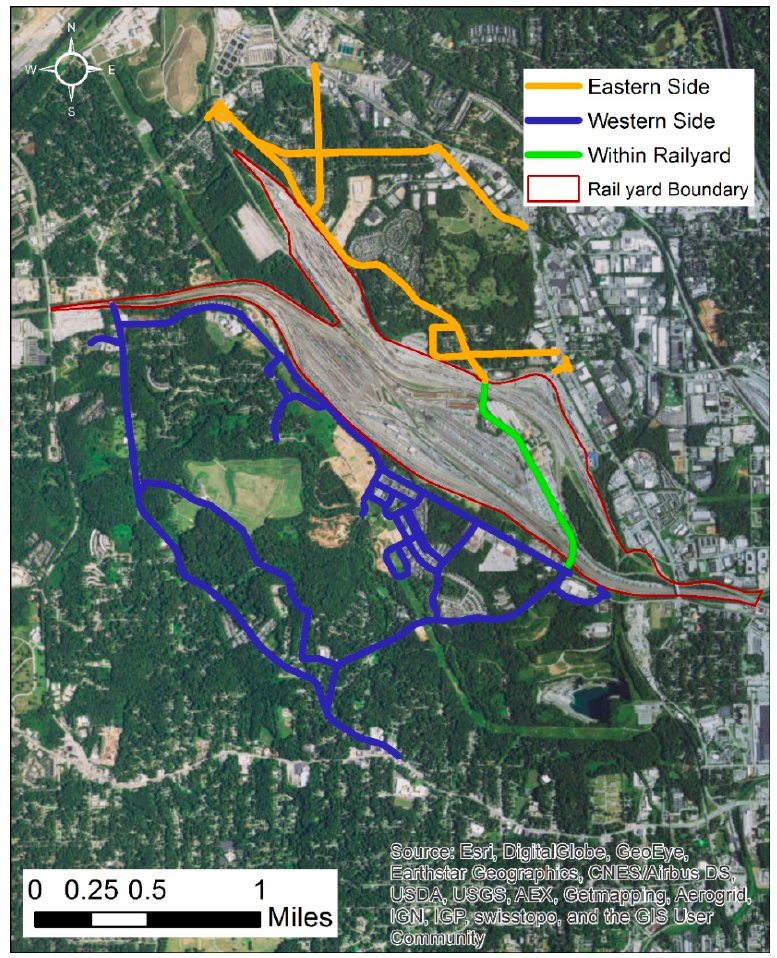
Figure 1. Map of conjoined Inman/Tilford rail yard areas with locations surveyed in detail by the mobile monitoring laboratory shown in blue (western side), green (crossing through the rail yard), and eastern side (orange).